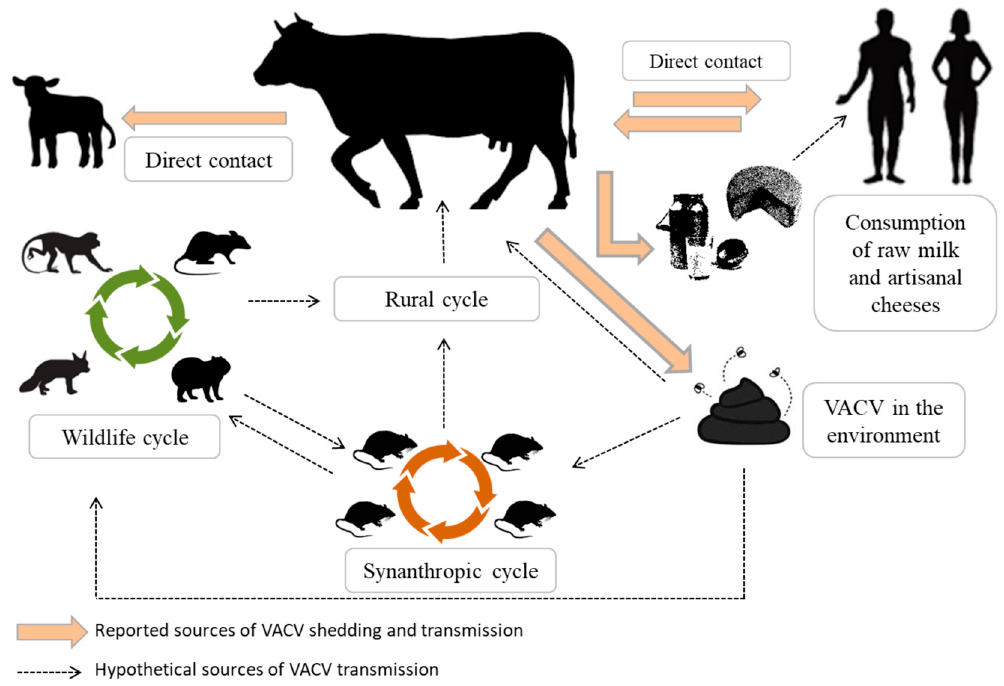
Figure 2. Reported and hypothetical sources of VACV transmission from a cow affected by bovine vaccinia (BV). Lesions are a source of VACV transmission by direct contact, and the virus could be eliminated via feces and milk. Bovine feces contaminated with VACV may be responsible for viral maintenance in the environment. Contaminated milk may be a source of VACV transmission via consumption, also to humans.